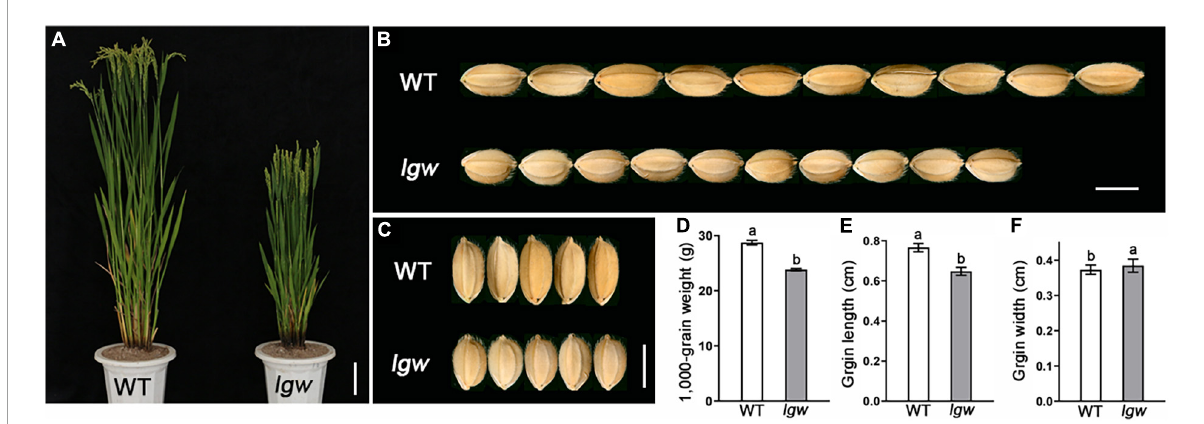
FIGURE1 Comparison of the grain size between wild type (WT) and lgw . (A) Three-month-old plant of wild-type (WT) and lgw mutant. Bar = 10 cm. (B,C) Observation of grain length (B) and grain width (C) of WT and lgw . Bar = 0.5 cm. (D) 1,000-Grain weight. (E) Grain length. (F) Grain width. Error bars represent SE ( n = 30). Different letters denote significant differences ( P < 0.05) from Duncan’s multiple range test.